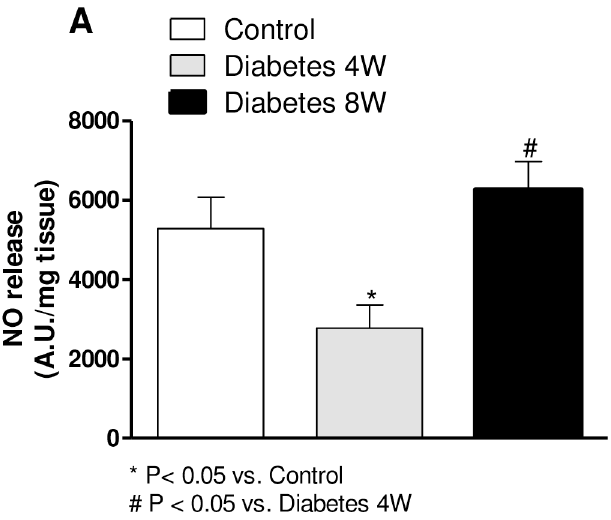
Fig 2. Effect of four (4W) or eight weeks ’ (8W) diabetes on EFS-induced NO release in rat mesenteric arteries. Results (mean ± SEM) are expressed as arbitrary (A.U.) (cid:1) mg − 1 tissue. One way ANOVA, * P < 0.05 vs . control, #P < 0.05 vs . N = 5 – 7 animals per